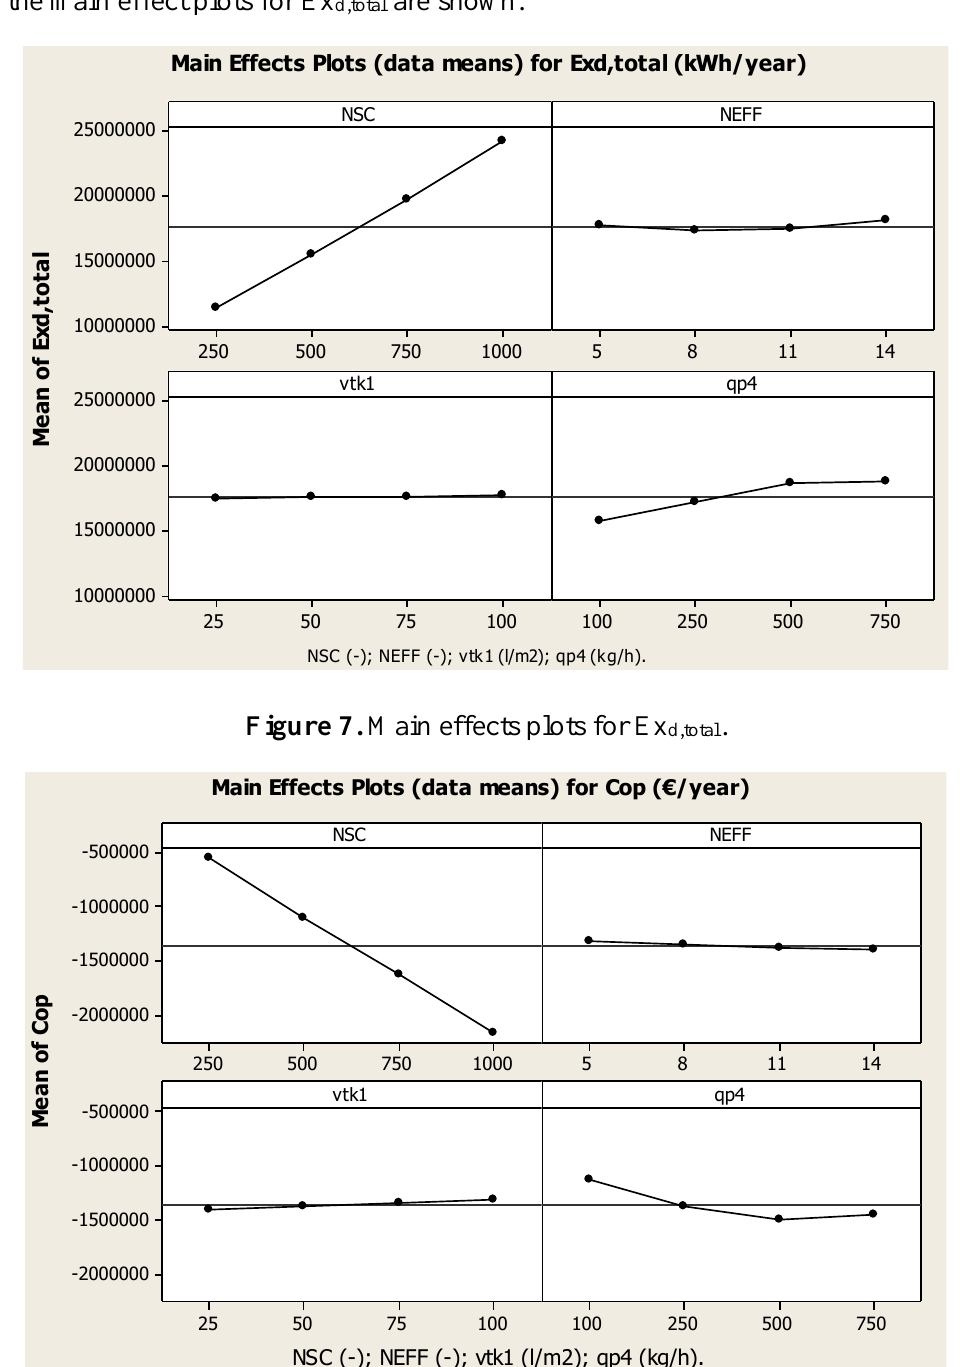
Figure 8. Main effects plots for C op